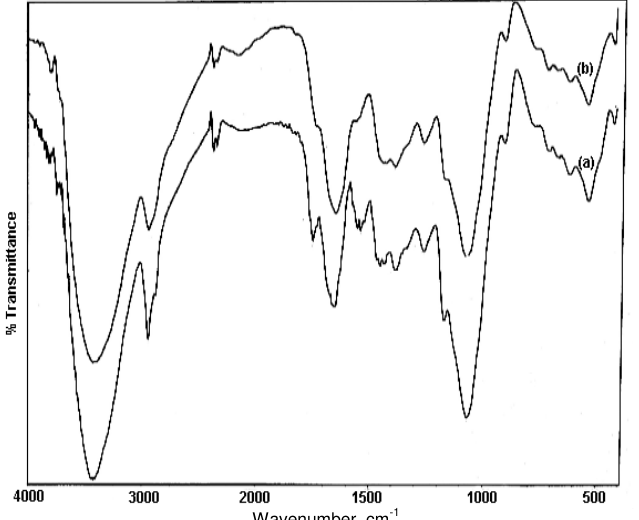
Figure 1. FTIR spectra of fungus (a) Before adsorption and (b)After adsorption of